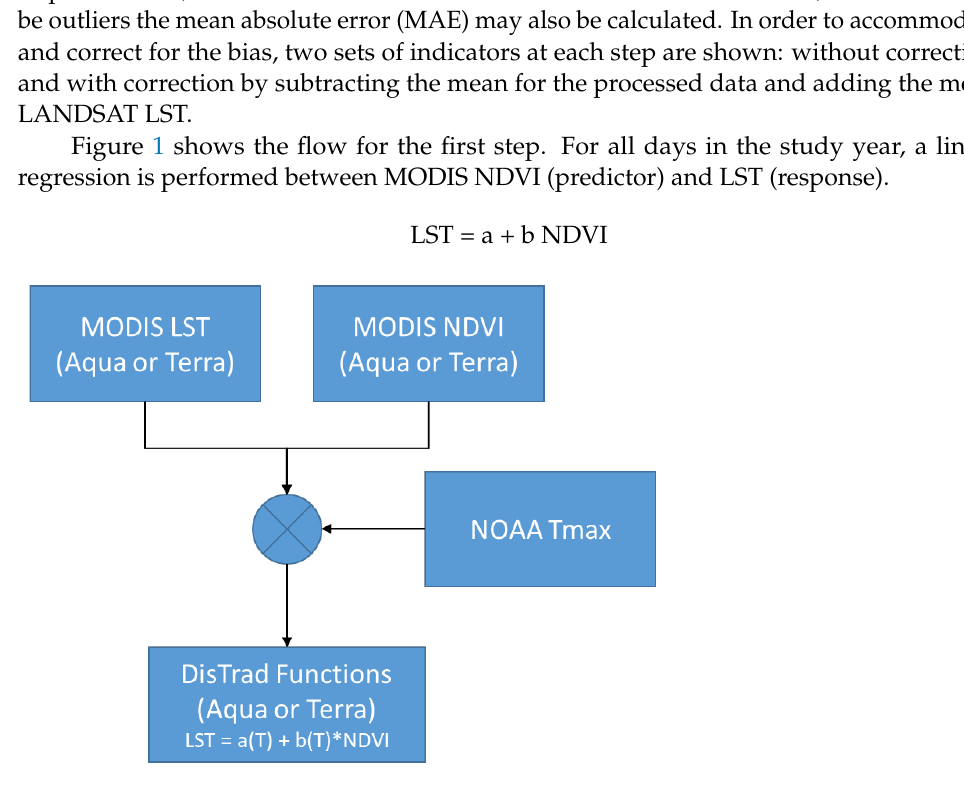
Figure 1. Flowchart—step 1—Temperature variable DisTrad functions. All pixels are used in the regression. The regression parameters (intercept and